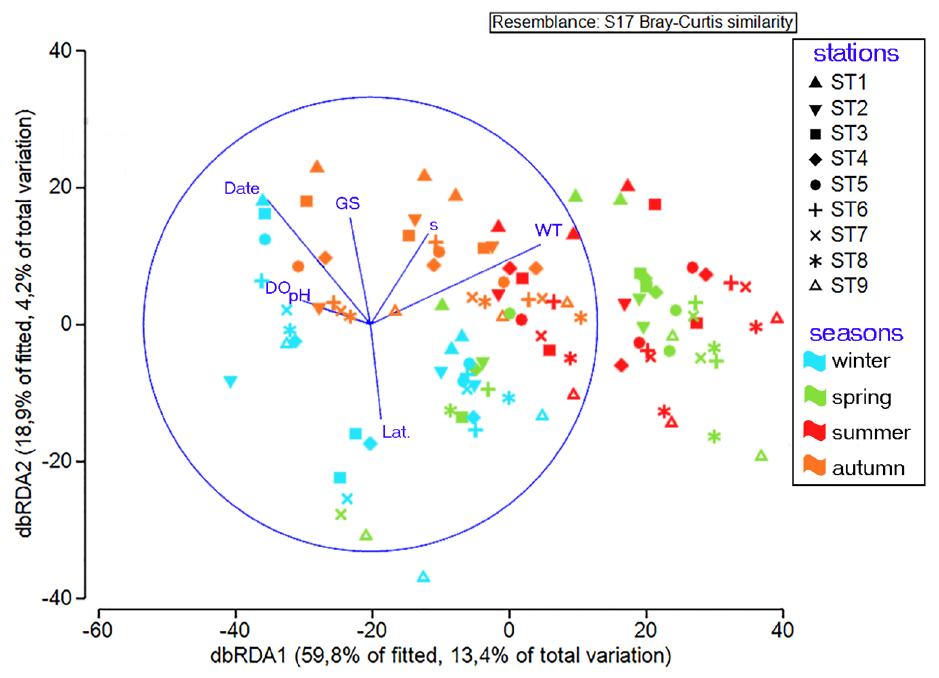
Figure 5. Distance-based Redundancy Analysis (dbRDA) plot for the harpacticoid community and environmental